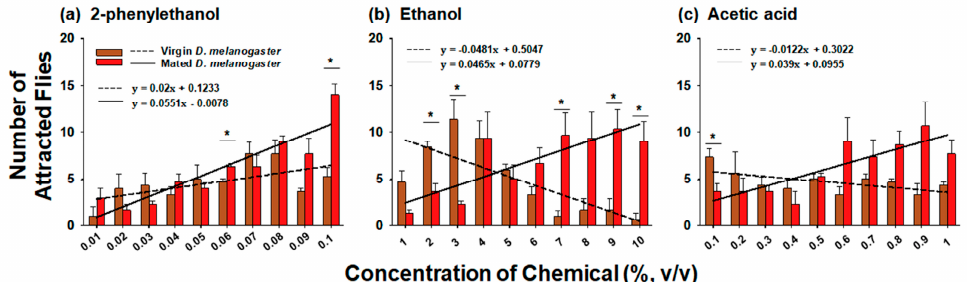
Figure 4. Comparison of the Y-tube choice behavior between virgin and mated female Drosophila melanogaster to ( a ) 2-phenylethanol, ( b ) ethanol, and ( c ) acetic acid. Twenty flies were introduced into the entrance of the olfactometer, and the number of flies that entered the side arms was counted. At the given concentration of the chemicals, Student’s t -test was used to compare chemical preference between virgin and mated females. Asterisks indicate significant differences ( p < 0.05). The data are presented as the mean ± standard error.